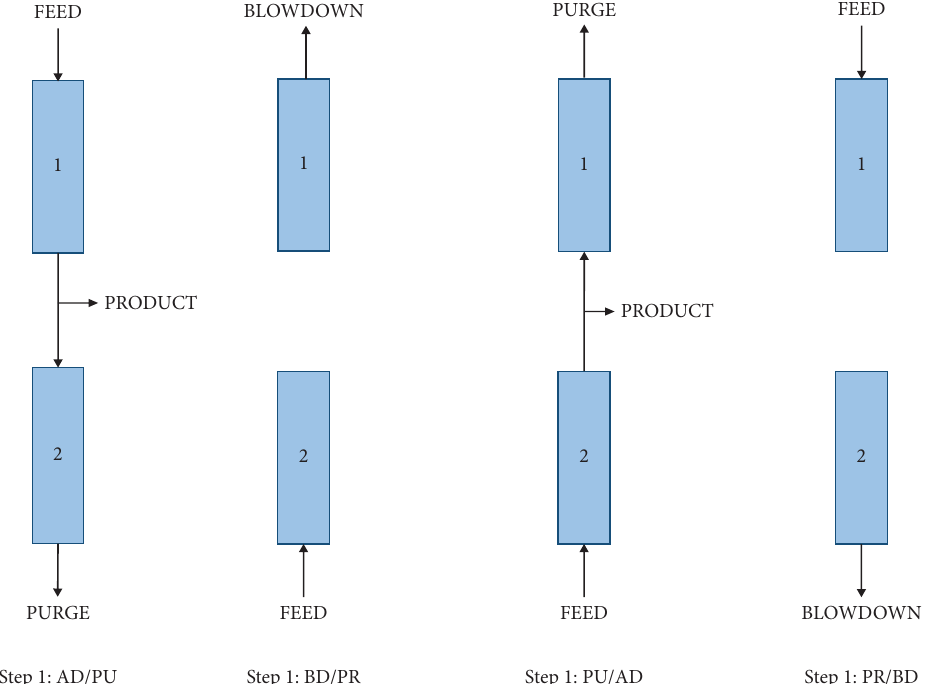
Figure 1: Te typical two-bed, four-step Skarstrom cycle adapted from